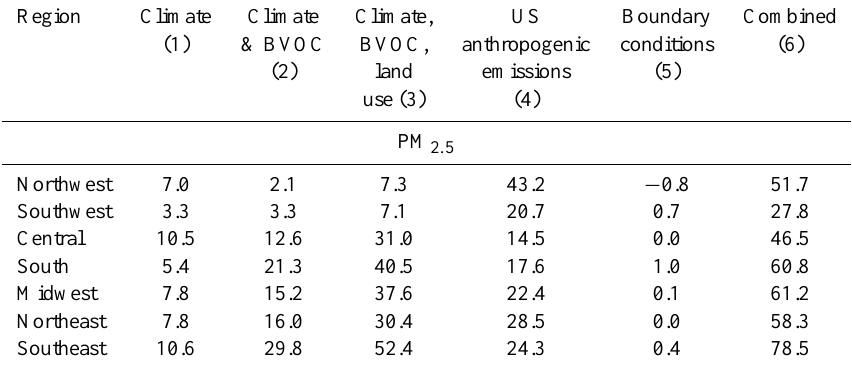
Table 5. Percent change of PM 2 . 5 between each future scenario and the current decade base case. The corresponding simulation number is shown is